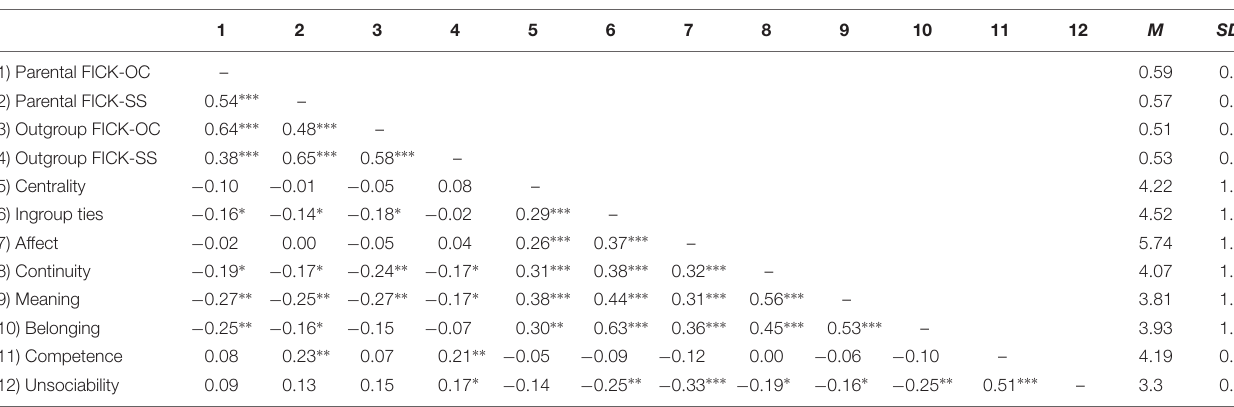
TABLE 2 | Descriptive statistics and intercorrelations of Study